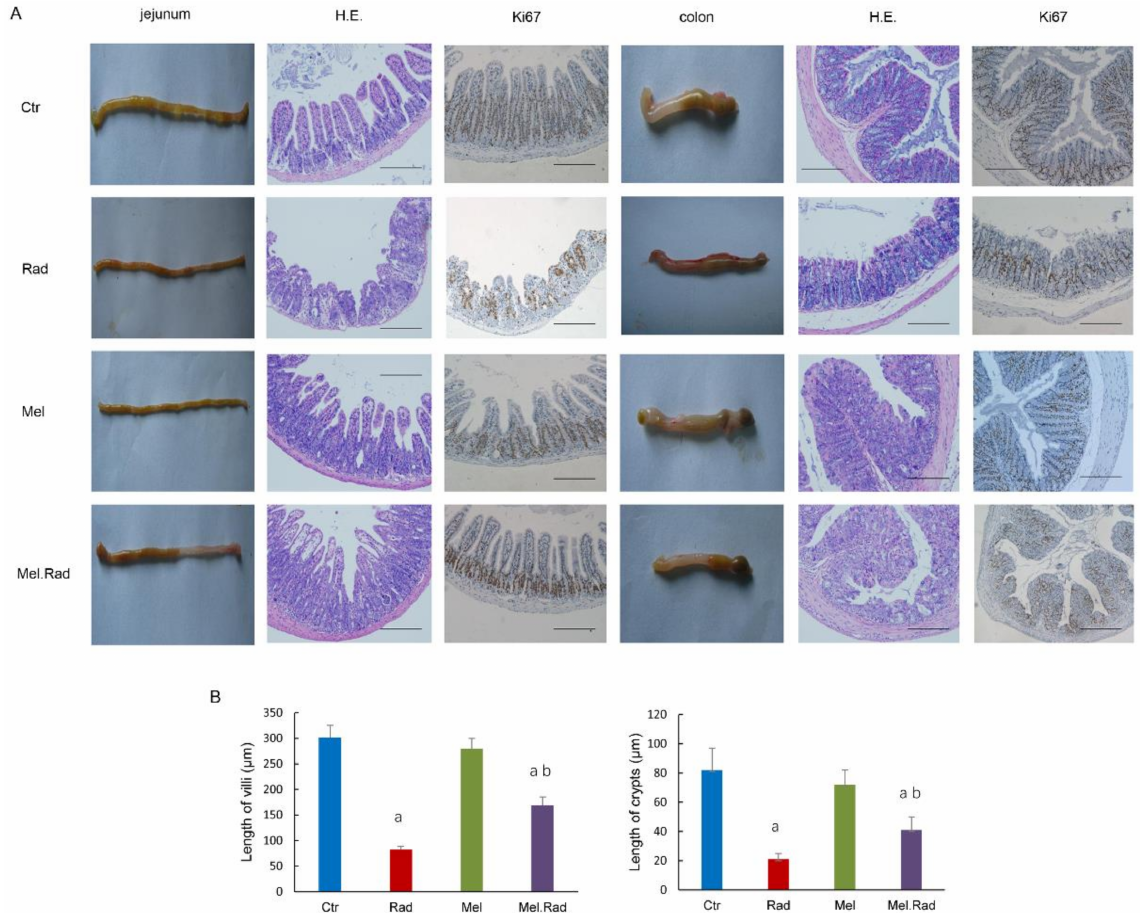
Figure 3. Effects of melatonin on the histomorphology of the intestines of mice following ABI. Mice were treated with melatonin (10 mg/kg) daily for 5 consecutive days by intraperitoneal injection before exposure to a dose of 14 Gy ABI. A group of sham-irradiated control mice was regarded as a control. The jejunum and the colon were dissected for pathological examination at 3 days after radiation. ( A ) Representative pictures of the intestines, H.E. staining, and Ki67-staining. ( B ) The length of villi and crypt of the jejunum. Data are represented as mean ± SD, n = 6 mice/group. a p < 0.05 vs. Ctr; b p < 0.05 vs. Rad. Scale bar, 100 µ